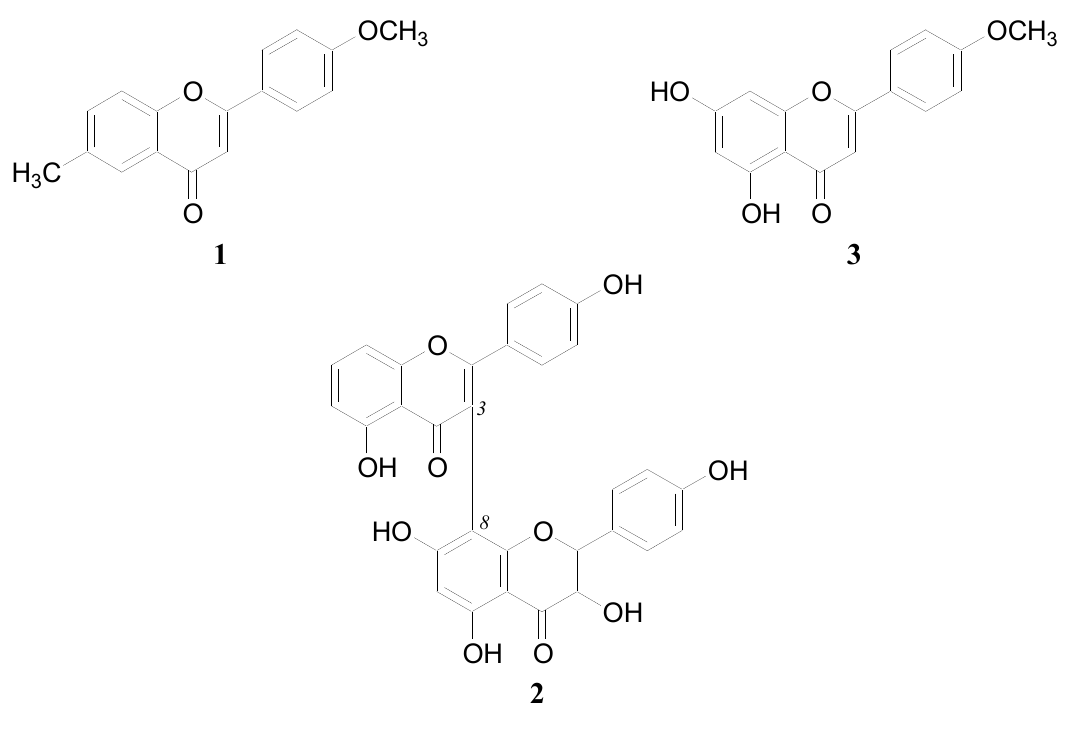
Figure 2. The chemical structures of compounds 1 , 2 and 3 .